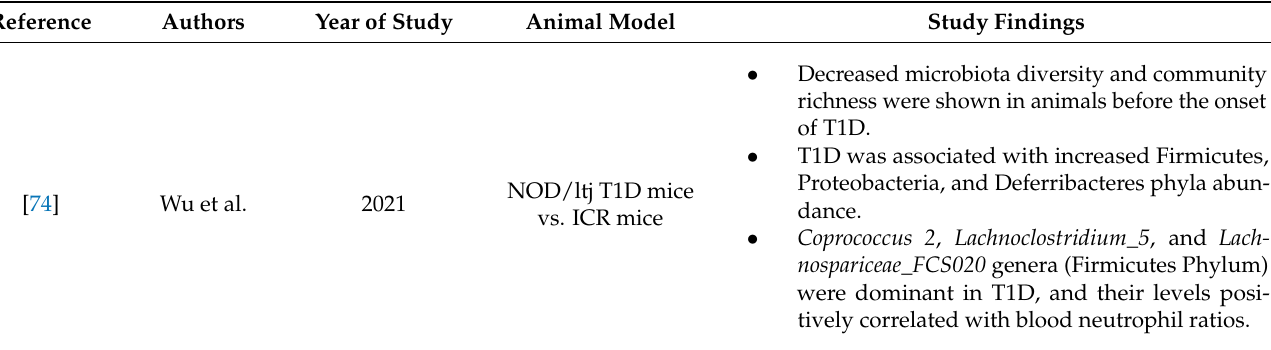
Table 1. Animal studies of the gut microbiota in